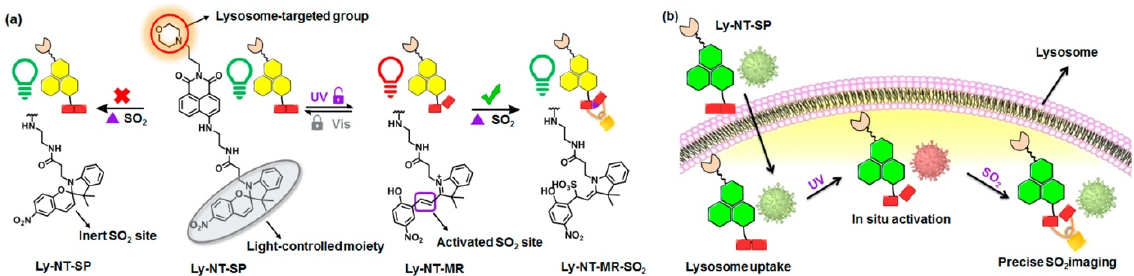
Figure 1. ( a ) Molecular design of 6 and proposed sensing mechanism; ( b ) Schematic illustration of in situ response of 6 controlled by UV irradiation. Reprinted with permission from ref. [13]. Copyright 2020 American Chemical Society.